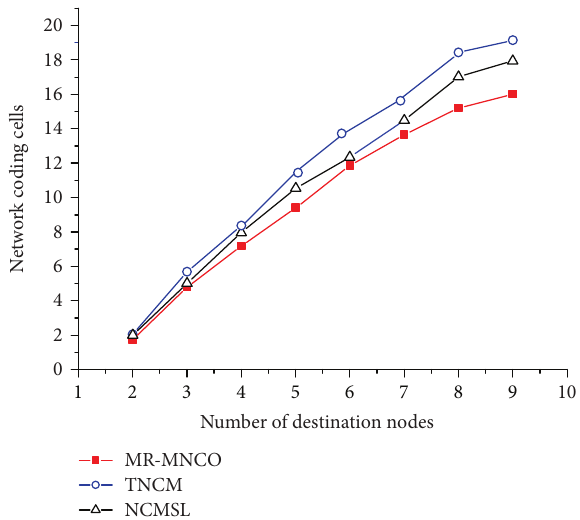
Figure 6: Probability of reaching multicast maximal capacity versus number of destination